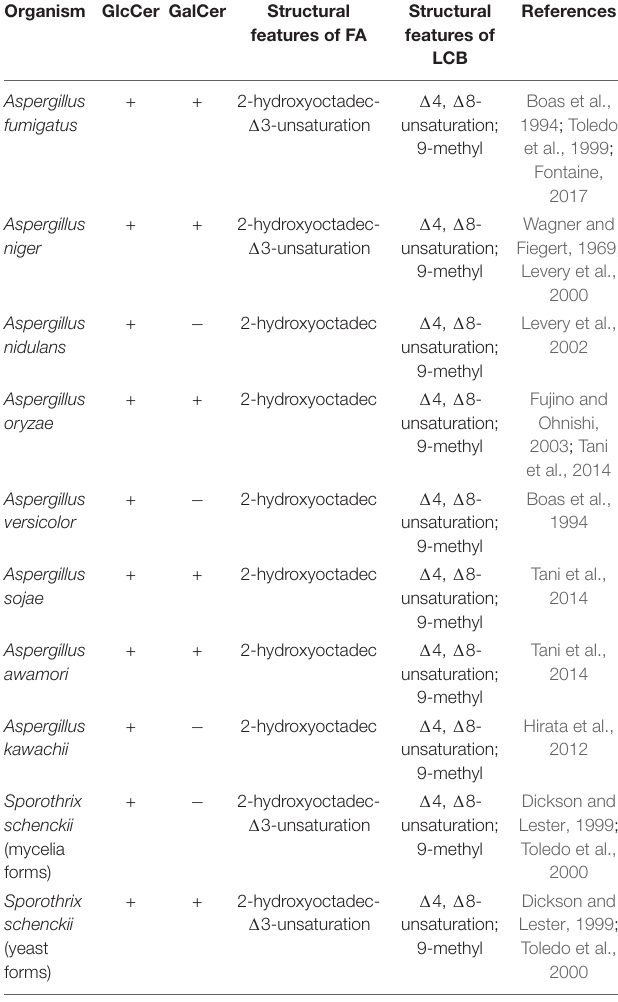
TABLE 1 | The type and structure of neutral GSLs in filamentous fungi. Organism GlcCer GalCer Structural features of FA